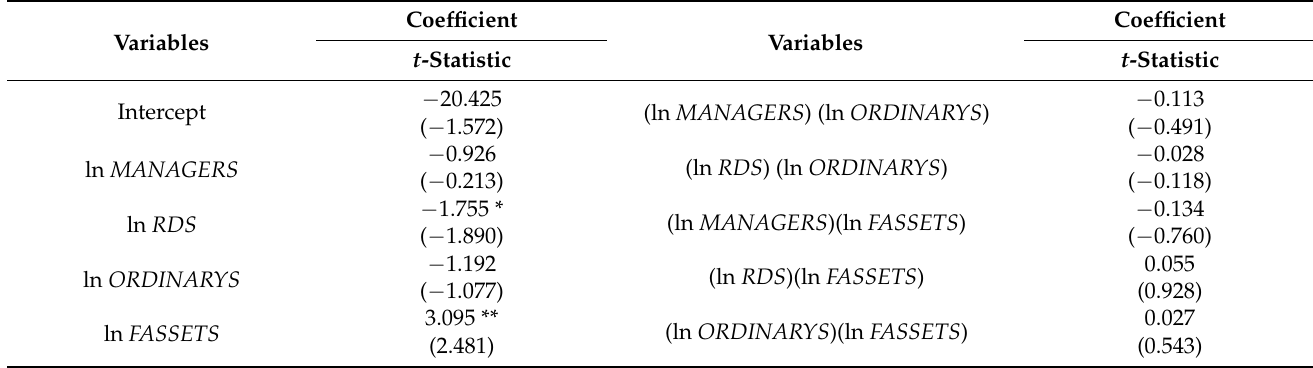
Table 4. Coefficient estimates for variables in this study ( t –statistics in